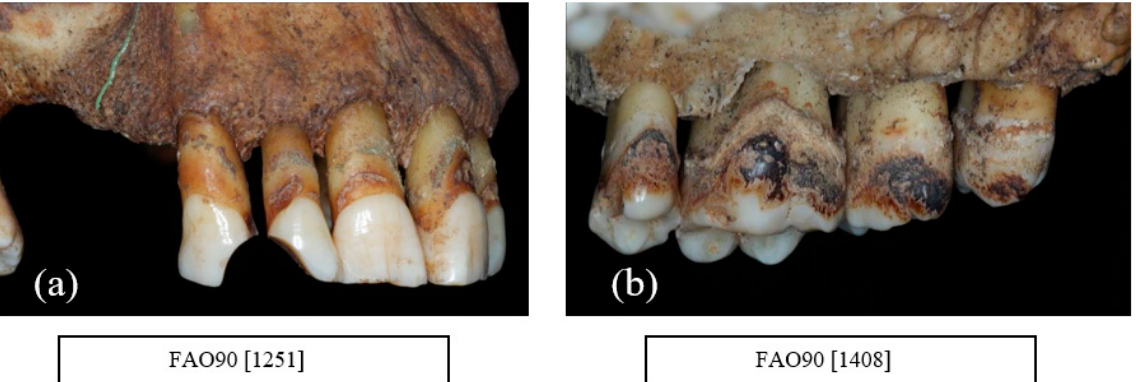
Figure 10. A total of 14% of individuals showed signs of smoking as indicated by ( a ) a pipe facet between the upper right second incisor (UR2) and canine (UR3) (FAO90 [1251]) and ( b ) staining of the maxillary teeth (FAO90 [1408]) (courtesy of the Museum of London).